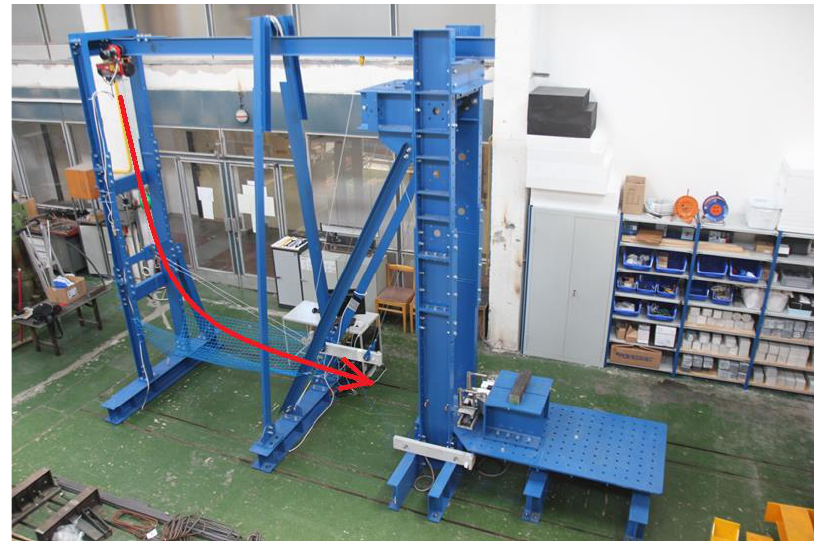
Figure 4. Pendulum.